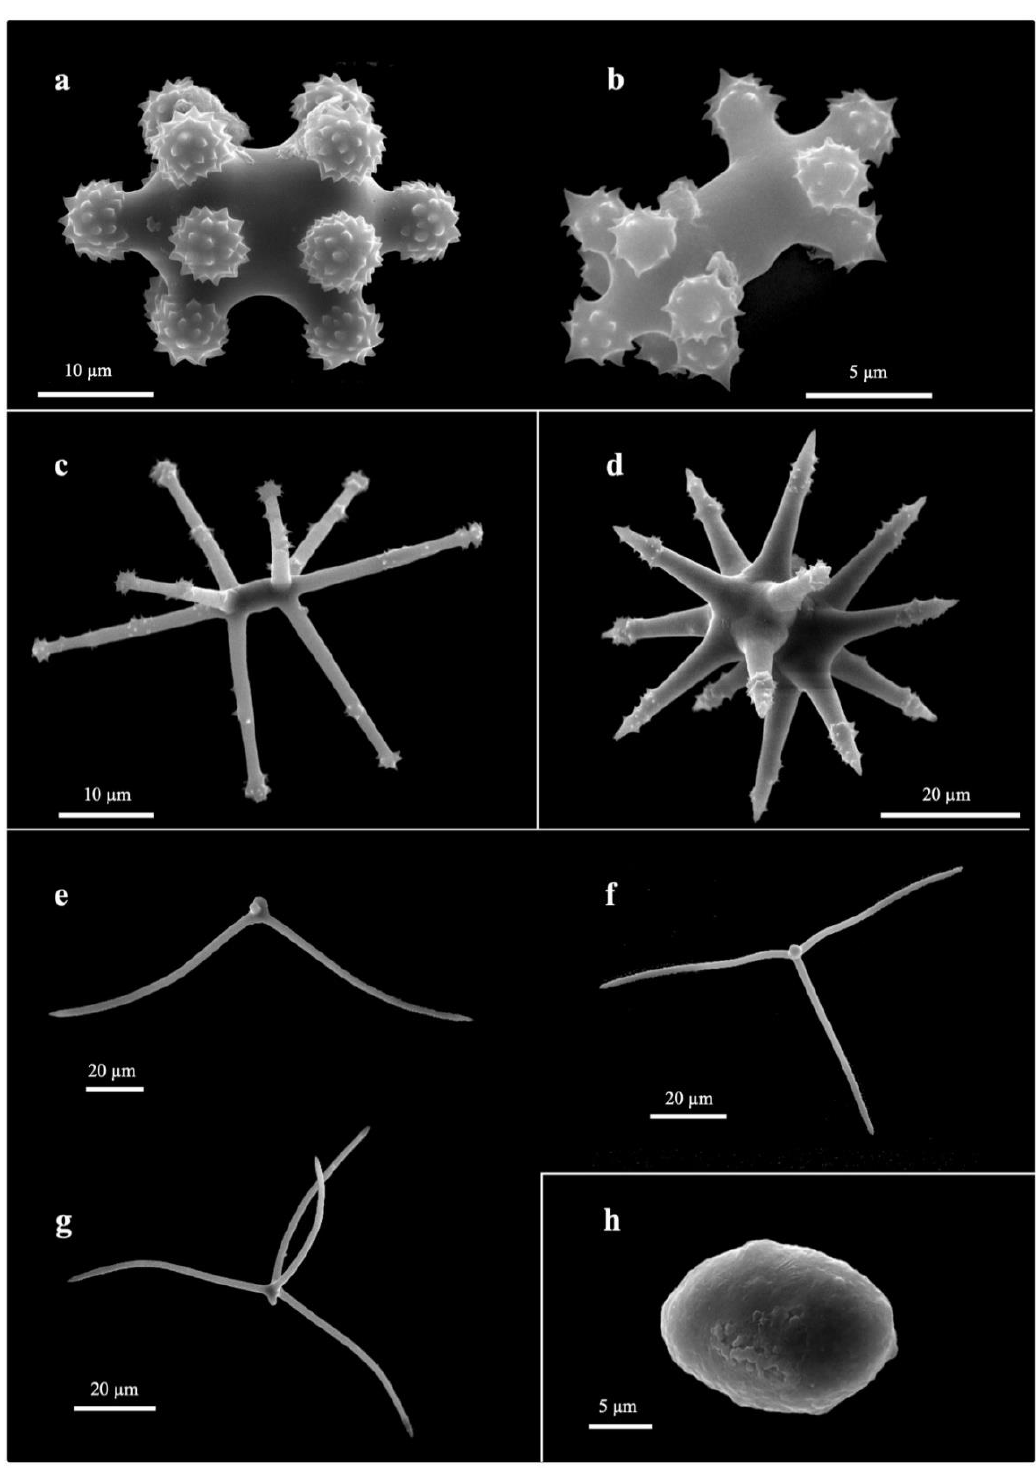
Figure 7. Spicule composition of Thoosa armata . SEM images: ( a ) typical nodular amphiaster; ( b ) nodular amphiaster with thinner axis; ( c ) amphiaster with six, straight and long rays arranged in two verticils; ( d ) larger amphiaster with pointed tips surrounded by small spines; ( e ) biradiate oxyaster; ( f ) biradiate oxyaster becoming triradiate; ( g ) oxyaster with four rays; ( h ) ovoid accessory microsclere.